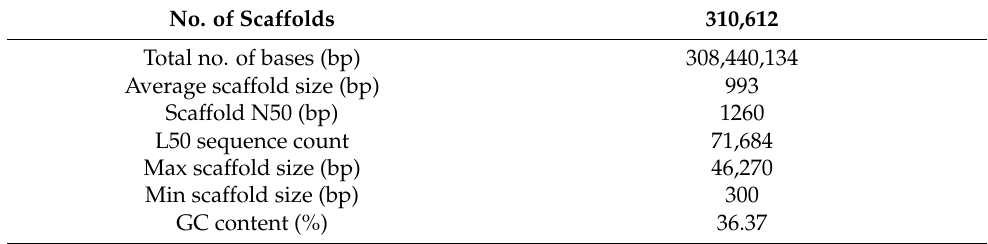
Figure 1. Genome size estimation through flow cytometry analysis: ( A ) histograms of propidium iodide fluorescence intensity for Drosophila melanogaster standard references used in the study. ( B ) Histograms of propidium iodide fluorescence intensity in Scirpophaga incertulas with Drosophila melanogaster as a standard reference. Table 1. Mean average value detected in flow cytometry. Table 2. Genome